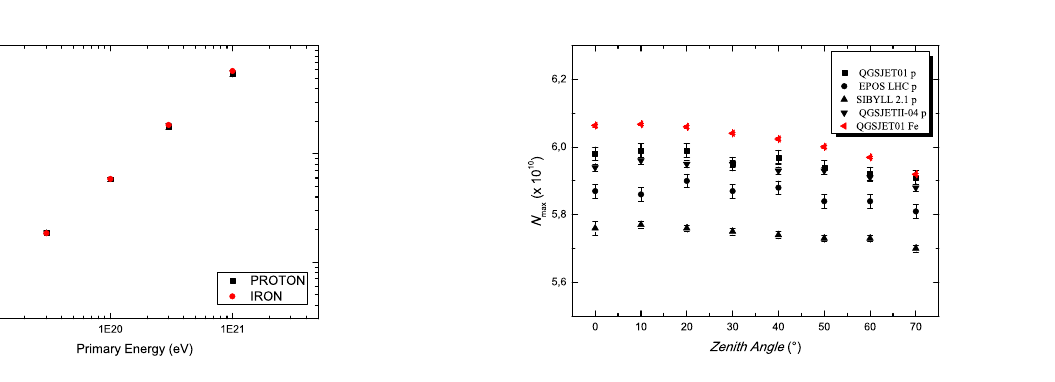
Figure 6. The maximum charged particles number N max as func- tion of the zenith angle of primary proton (Black) iron (red) with energy equals 10 20 eV .